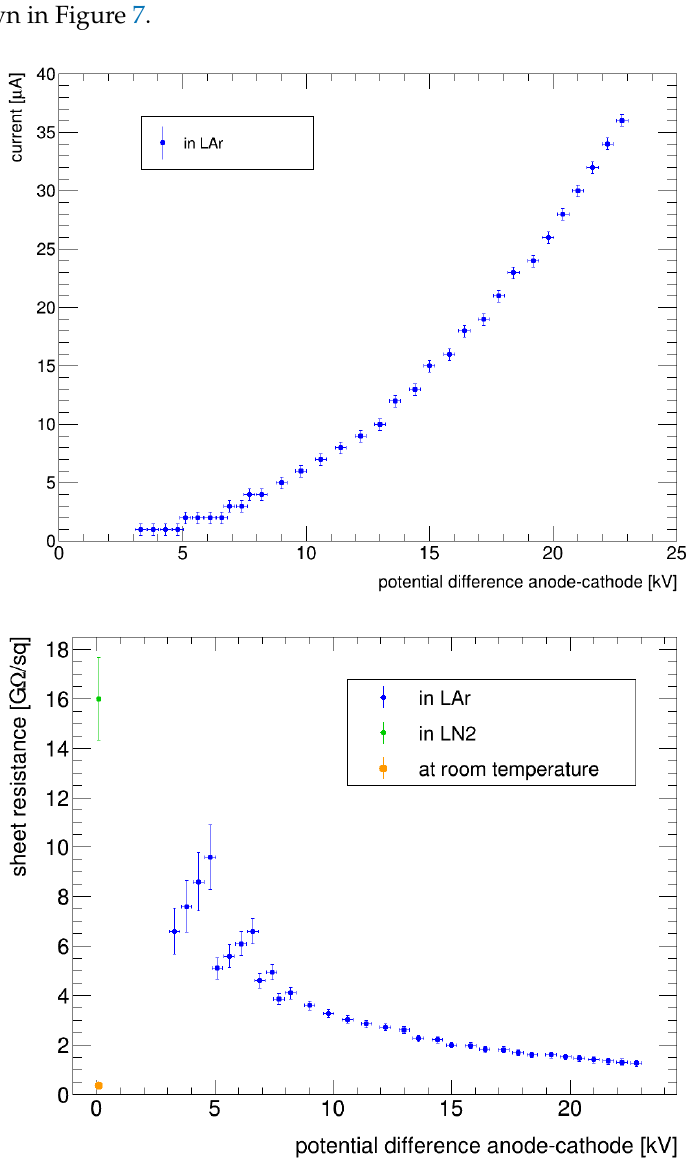
Figure 7. The shell’s current and sheet resistance as a function of the cathode bias